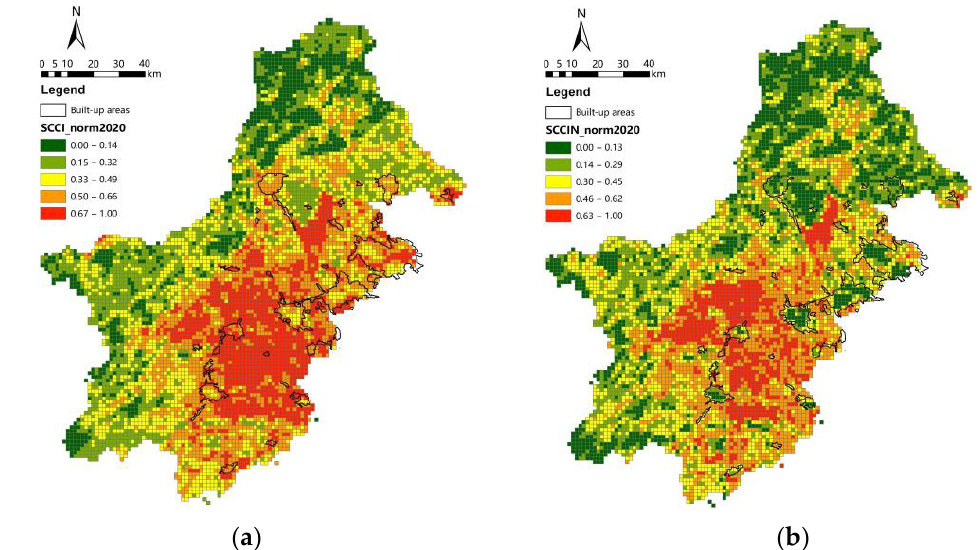
Figure 7. Distribution of land-use conflict index considering the landscape pattern in the year 2020. ( a ) Normalized land-use conflict using landscape ecological risk and ( b ) normalized land-use con- flict not considering the vulnerability index.